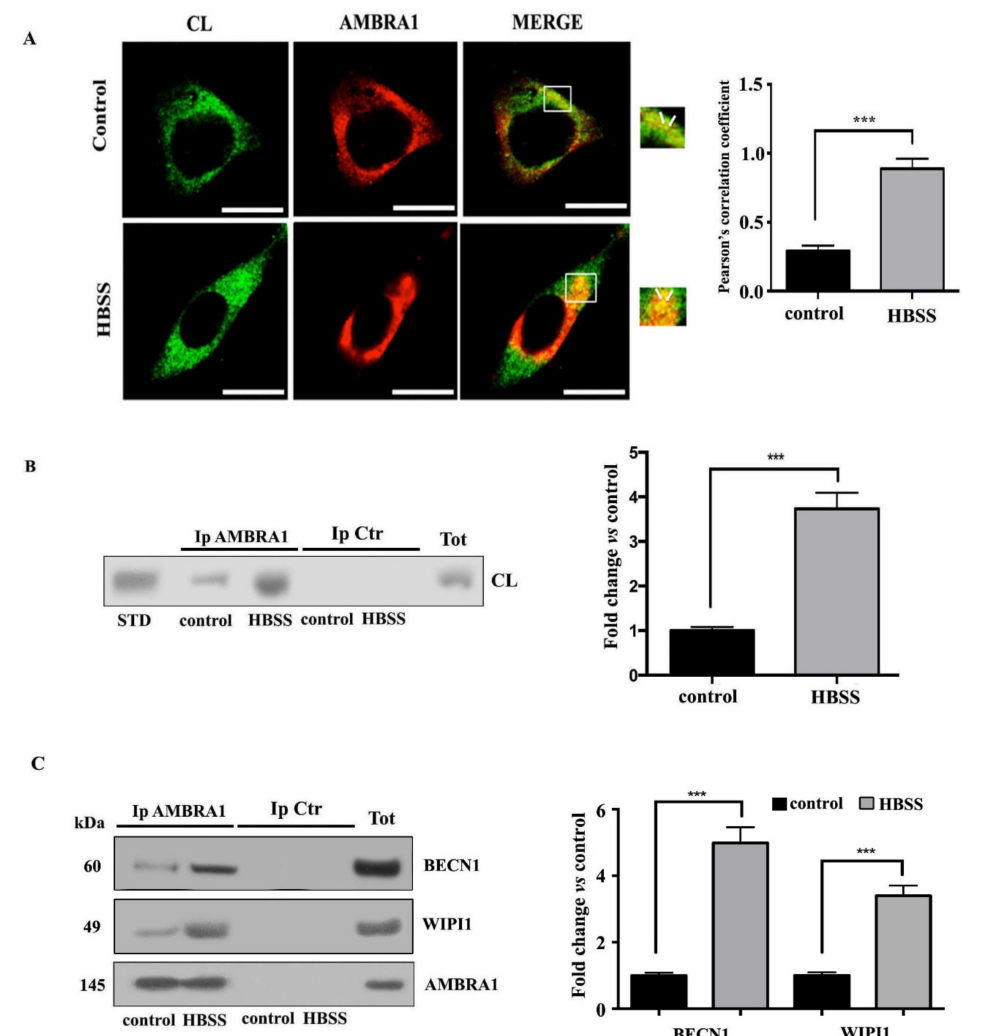
Figure 3. Cardiolipin/AMBRA1 association during autophagy induction in fibroblast cells. ( A ) Human 2FTGH (2F) fibroblasts untreated or treated with HBSS for 1 h were fixed with 4% paraformaldehyde in PBS for 30 min at room temperature and then permeabilized by 0.5% Triton X-100 in PBS for 5 min at room temperature; then cells were incubated with human anti-CL and rabbit anti-AMBRA1 PAb for 1 h. After washing, cells were incubated with Texas Red-conjugated anti-rabbit IgG or with FITC-conjugated anti-human IgG. The images were acquired with Olympus FV1000 spectral confocal laser scanning microscope. Pearson’s correlation coefficient was calculated. A minimum of 30 cells/sample was analyzed and the statistical analysis was performed using Student’s t -test, *** p ≤ 0.001. Scale bar, 5 µ m. ( B ) Human 2FTGH (2F) fibroblasts, untreated or treated as above, were lysed in lysis buffer, followed by immunoprecipitation with rabbit anti-AMBRA1. A rabbit IgG isotypic control (IpCtr) was employed. The immunoprecipitates were subjected to phospholipid extraction and analyzed by HPTLC immunostaining for the presence of CL. A positive control was obtained using pure standard CL (STD, Sigma-Aldrich). ( C ) The immunoprecipitates were checked for the presence of BECN1 and WIPI1 by Western blot analysis, using anti-BECN1, and anti-WIPI1 Mab. As a control, the immunoprecipitates were assessed by immunoblot with anti-AMBRA1 Mab. A representative experiment among 3 is shown. Bar graph on the right shows densitometric analysis. Results represent the mean ± SD from 3 independent experiments. *** p ≤ 0.001, HBSS vs control